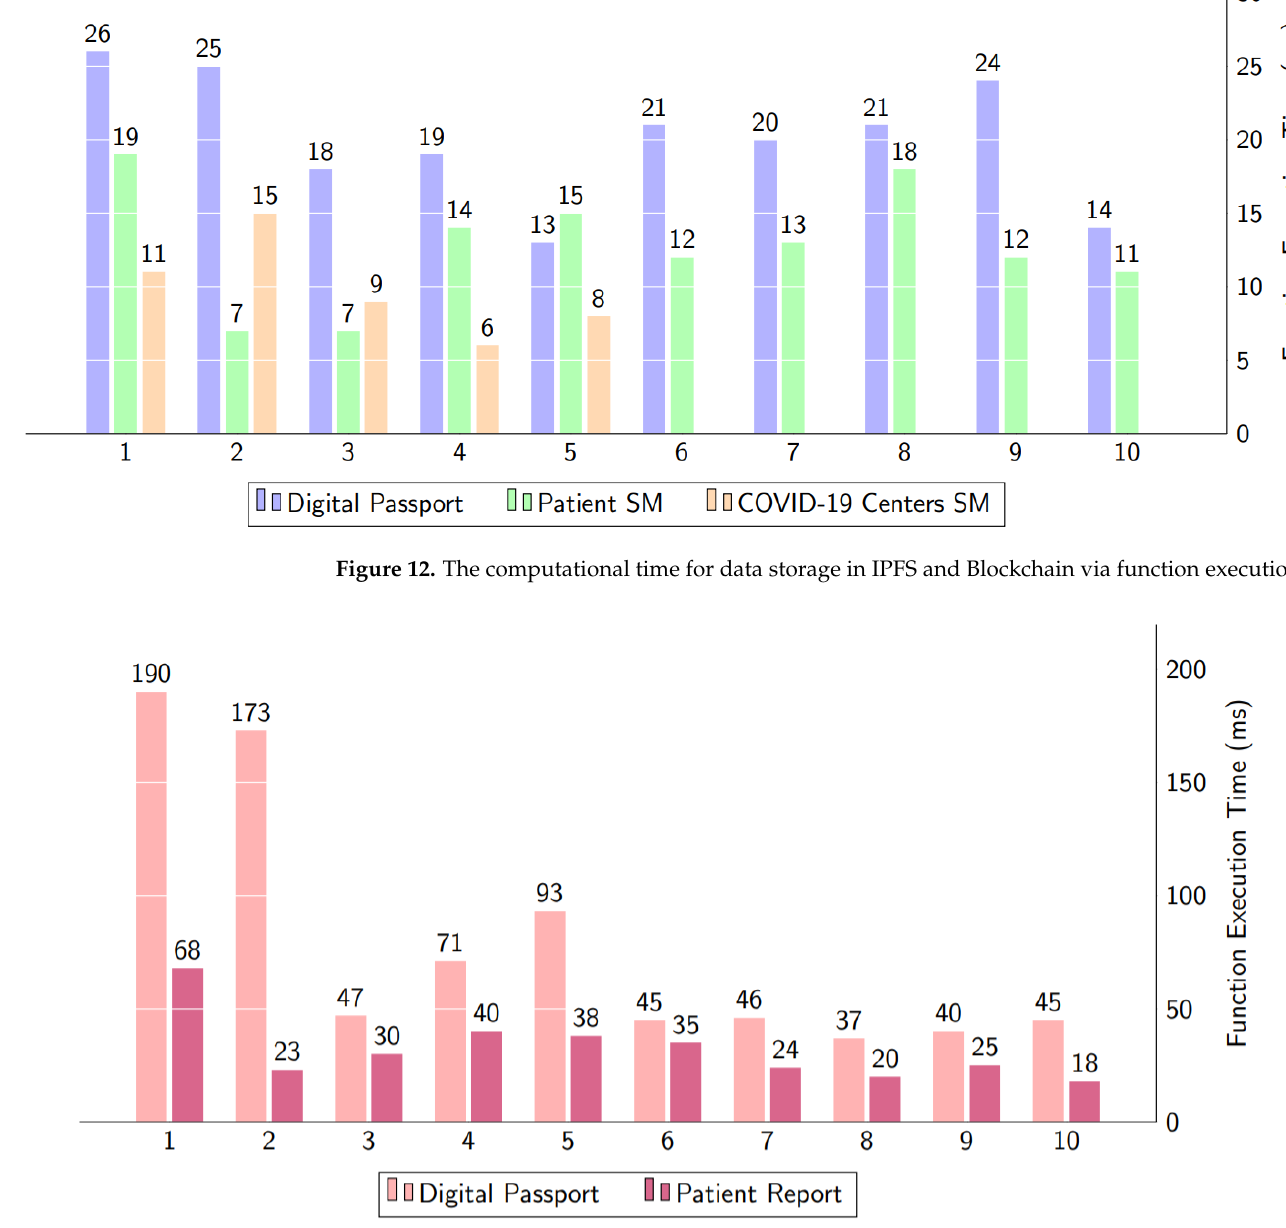
Figure 13. The computational time for accessing data from IPFS and Blockchain.